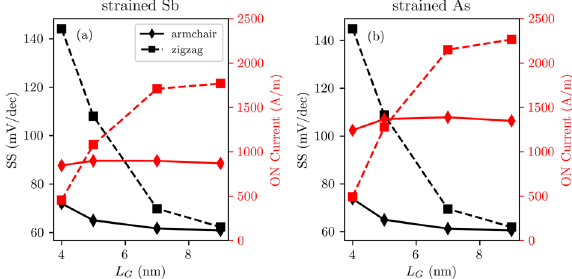
Fig. 7 Figures-of-merit of the MOSFETs with strained Sb and As. ON current and SS as a function of the gate length L G extracted from the transfer characteristics in Fig. 6 of the MOSFETs based on a strained antimonene (Sb) and b arsenene